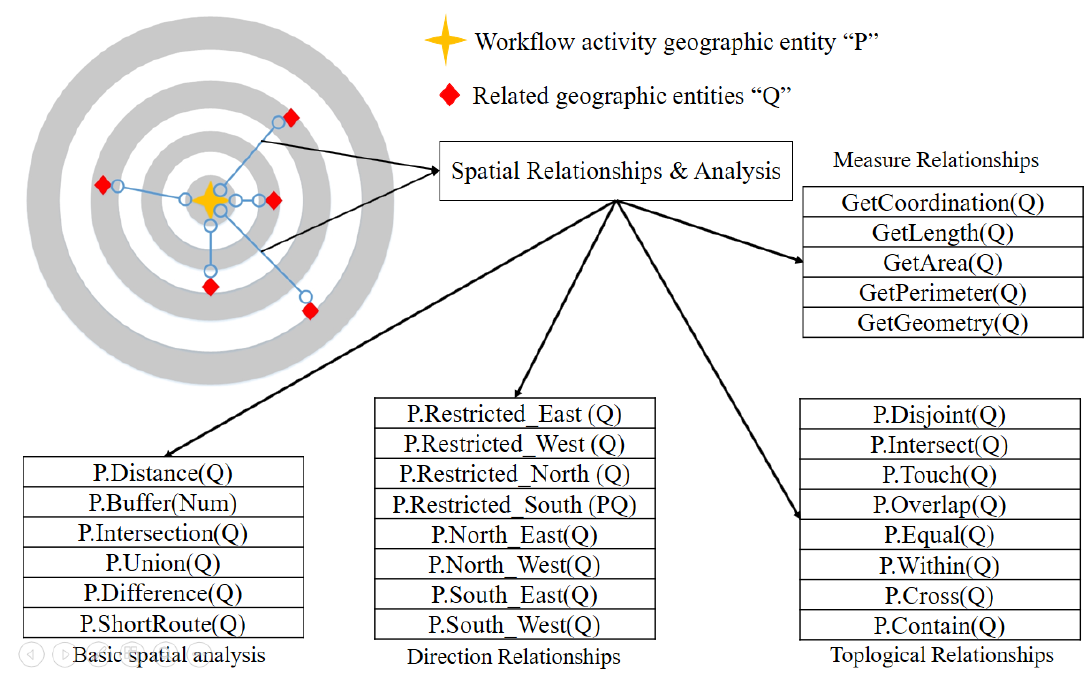
Figure 1. Semantic description of spatial relationships and basic analysis in workflow